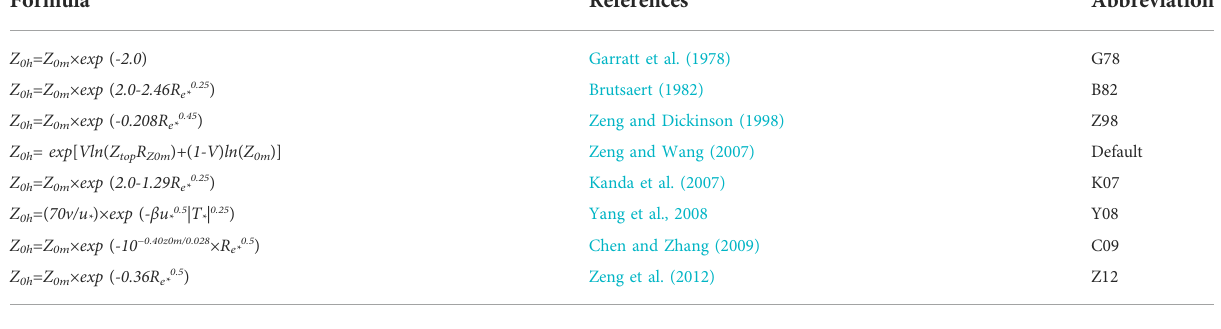
TABLE 3 Introduction of thermal roughness characterization scheme, where fl uidkinematicviscosity ( ν )[= 1.5×10 – 5 m 2 s − 1 ], β =7.2, Re* = Z 0m ×u*/ ν ,Z top is canopy top height (m) , R Z0m is the ratio of momentum roughness length. Formula